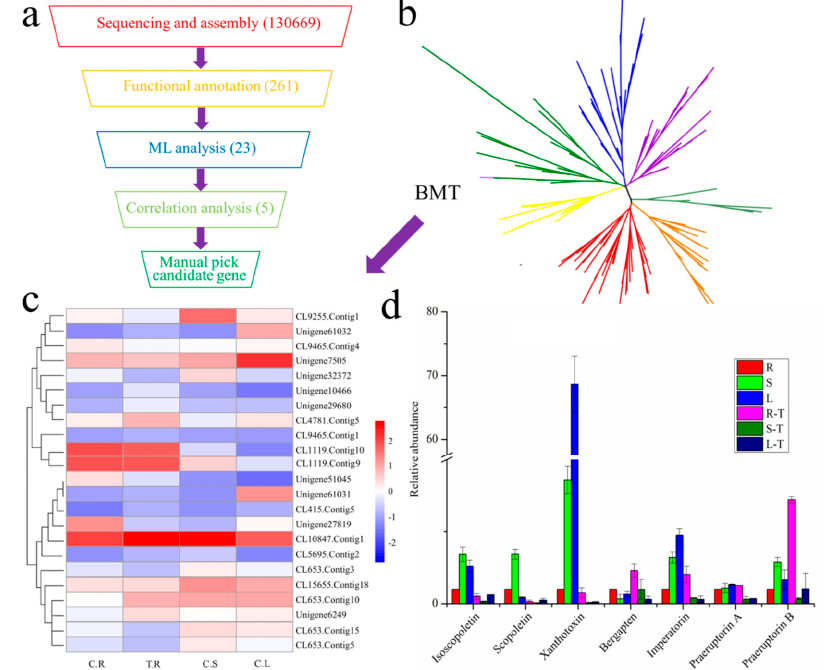
Figure 1. Candidate genes mining using transcriptome sequencing and phytochemical analysis. ( a ) The overall experimental design of candidate genes mining used in this study. ( b ) Phylogenetic tree of all the 151 non-redundancy OMTs constructed by maximum-likelihood. Different OMTs are marked with different colors. Bergaptol O -methylation gene (corresponding to CL1119.contig10 in the present transcriptome dataset) was marked with pink to locate the candidate genes. ( c ) Expression heatmap of candidate genes and ( d ) relative abundance of main coumarins and all the O -methoxylated coumarins in P. praeruptorum . R, S, L, C, T represents root, stem, leaf, control (without treatment) and treatment with methyl jasmonate (MeJA), respectively. The abundance of each compound in root without treatment was used as reference and set as 1 for normalization. The data represent the means ± SD of 3 replicates and the folds to the